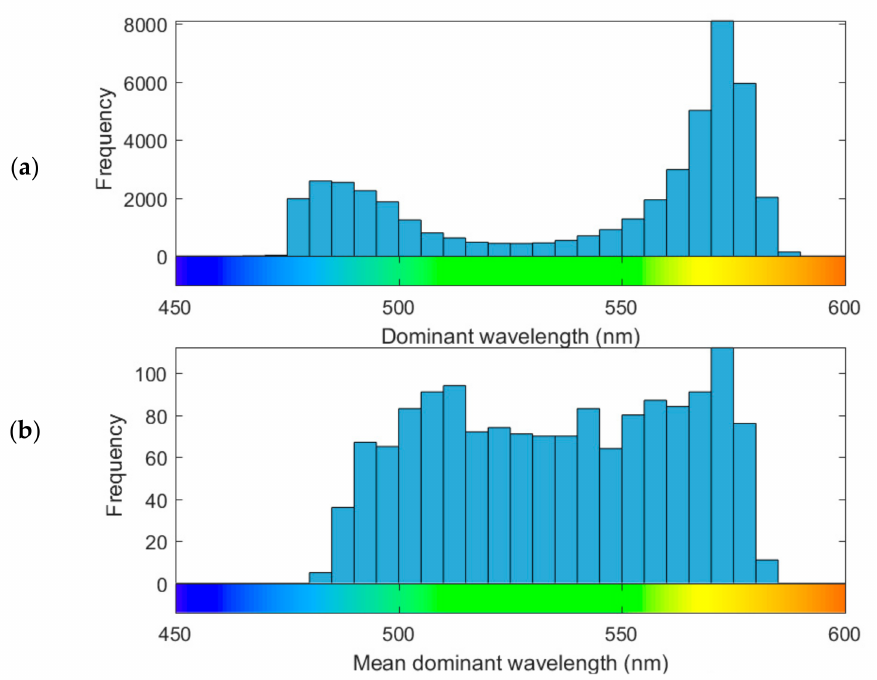
Figure 8. ( a ) Frequency histogram of 44,947 observations of dominant wavelength. ( b ) Frequency distribution of the mean dominant wavelength of 1486 lakes.